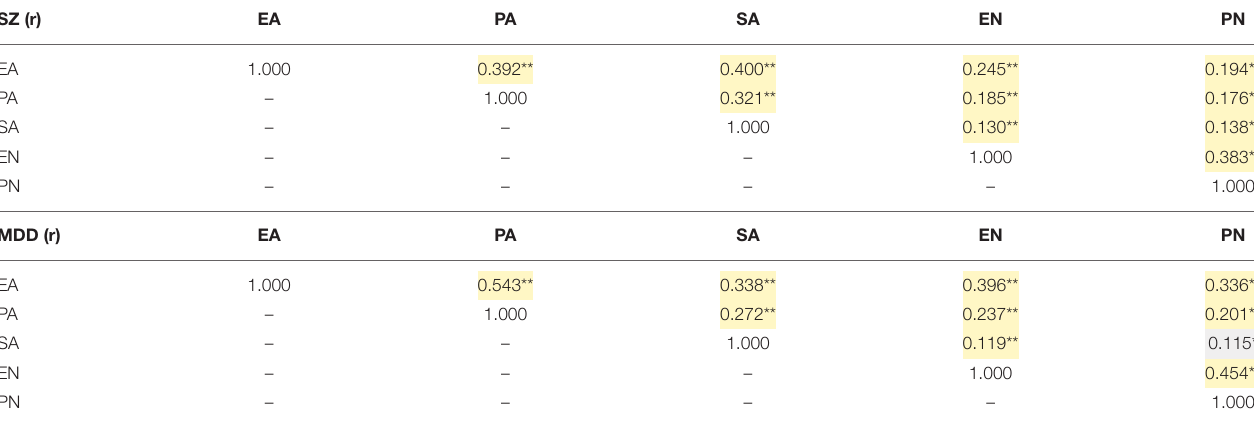
TABLE 3 | Correlations of different types of childhood traumatic experiences in patients with schizophrenia and those with major depressive disorder. SZ